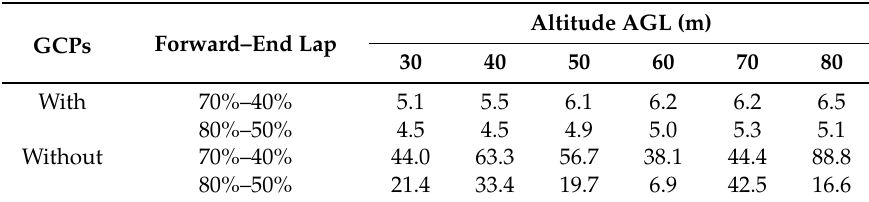
Table 4. Relative horizontal spatial deviation.